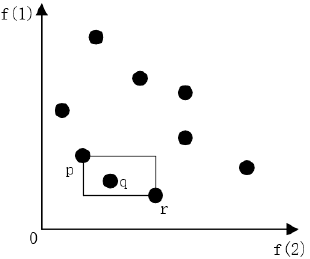
Figure 3. Schematic diagram of the crowded distance.